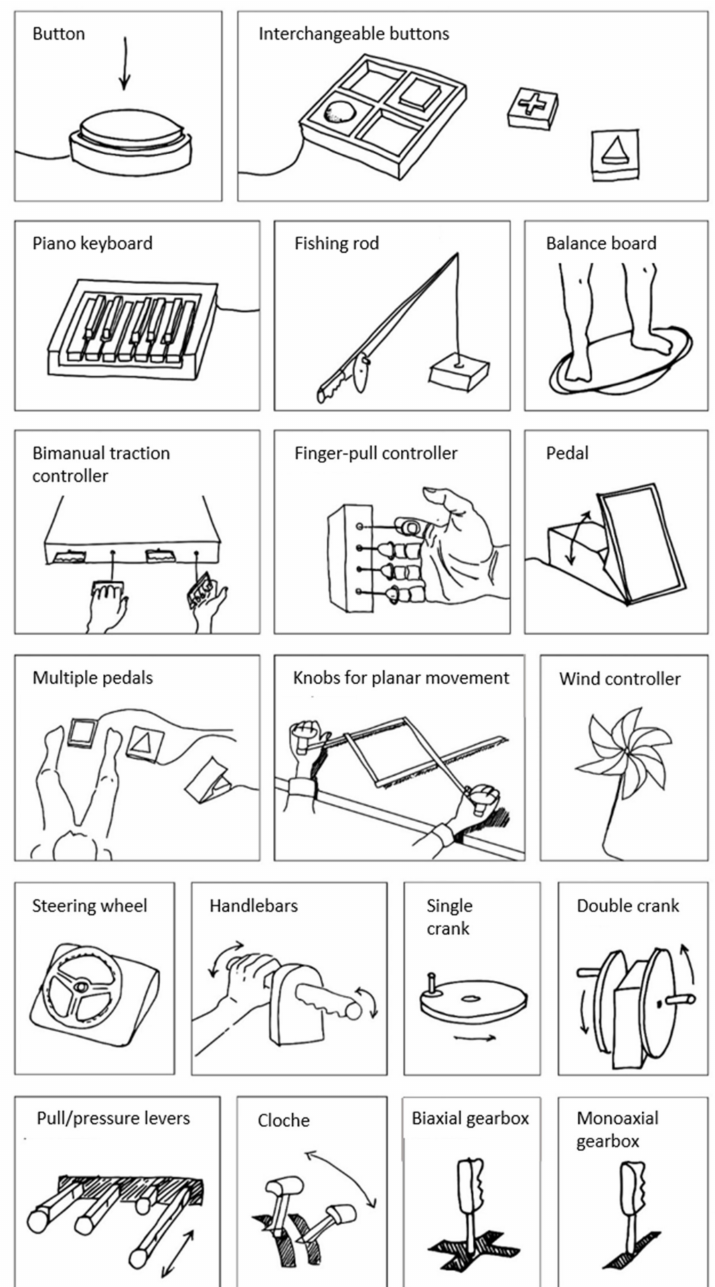
Figure 9. Game controllers proposed to the parents among which they had to select the most intriguing, the most enjoyable, and the one that their child would use the